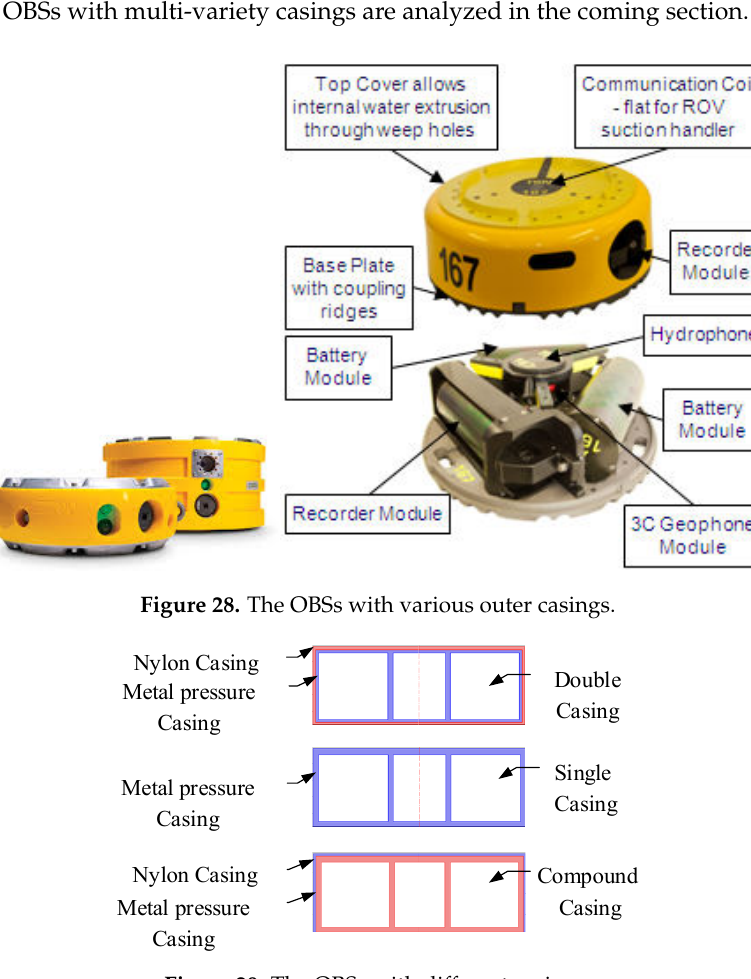
Figure 29. The OBSs with different casings.